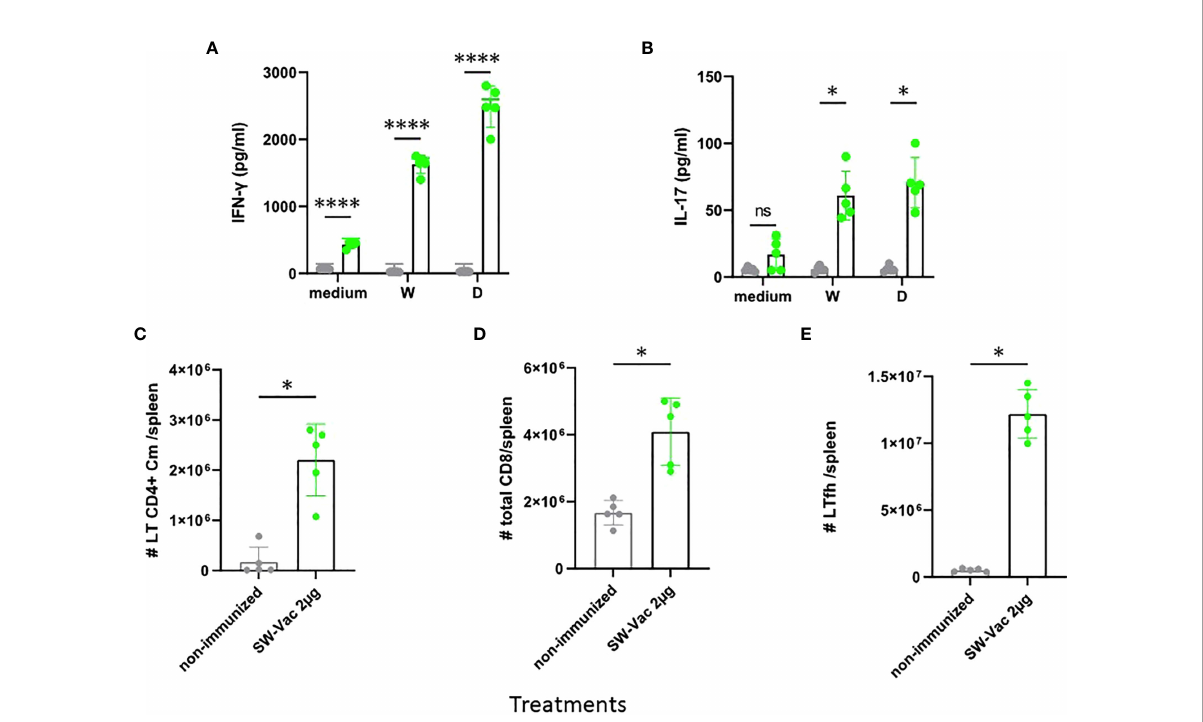
FIGURE 5 SW-Vac 2µg formulation induces Ag-speci fi c Th1(IFN- g )/Th17 (IL-17), Tfh and CD8+ T cells in the spleen. BALB/c mice were vaccinated as described in previous fi gures. Mice were sacri fi ced 44 days after the second immunization to obtain spleens, and T-cell response was evaluated. Levels of secreted IFN- g (A) and IL-17 (B) following splenocytes stimulation with medium or recombinant spike protein from W o D variants were determined by ELISA. Bars are means ± SEM of pg/ml of IFN- g and IL-17. *p<0.05, ****p<0.0001 t-test. For FACS analysis the spleen cells from immunized mice (green circles) and non-immunized (grey circles) were incubated with CD16/CD32 Fc g RII (1:100) to block IgG Fc receptors. Cells were incubated with LIVE/DEAD Violet (Invitrogen), followed by surface staining with fl uorochrome-conjugated anti-mouse Abs for various markers: CD3-Pe-Cy7 (BD), CD8-PE (BD), CD4-FITC (BD), CD44-PE (BD), CXCR5-PerCP-Cy5.5 (BD), CD127-APC (BD); CD4 + Cm: CD3 + CD4 + CD62L + CD44 + (C) ; CD8 + : CD3 + CD8 + (D) ; Tfh: CD3 + CD4 + CXCR5 + (E) . Flow cytometry analysis was performed on an BD FACSAria Fusion. The results were analyzed using FlowJo software (TreeStar).*p<0.05 t-test. Results are representative of two independent